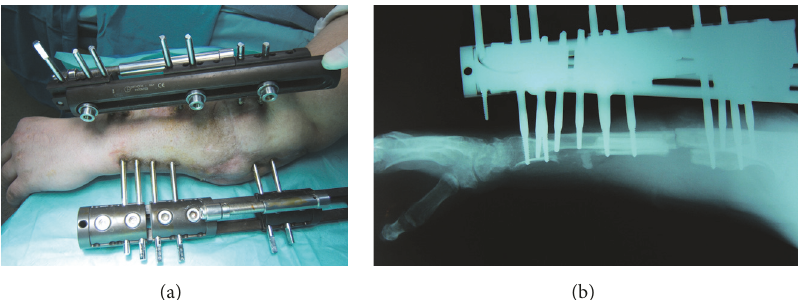
Figure 2: One external fixator was applied to each bone, radius, and ulna. They were used for segmental bone transportation of the radius and later distraction osteogenesis of both radius and ulna.